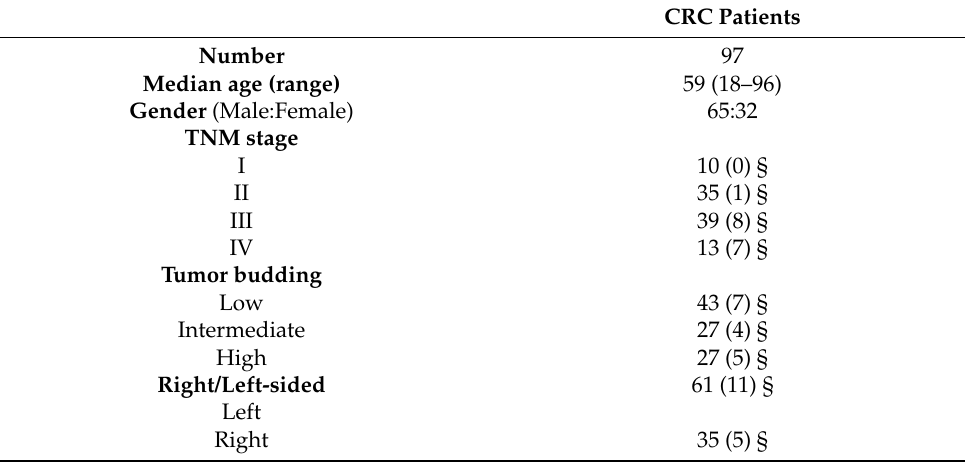
Table 1. Characteristic features of colorectal cancer